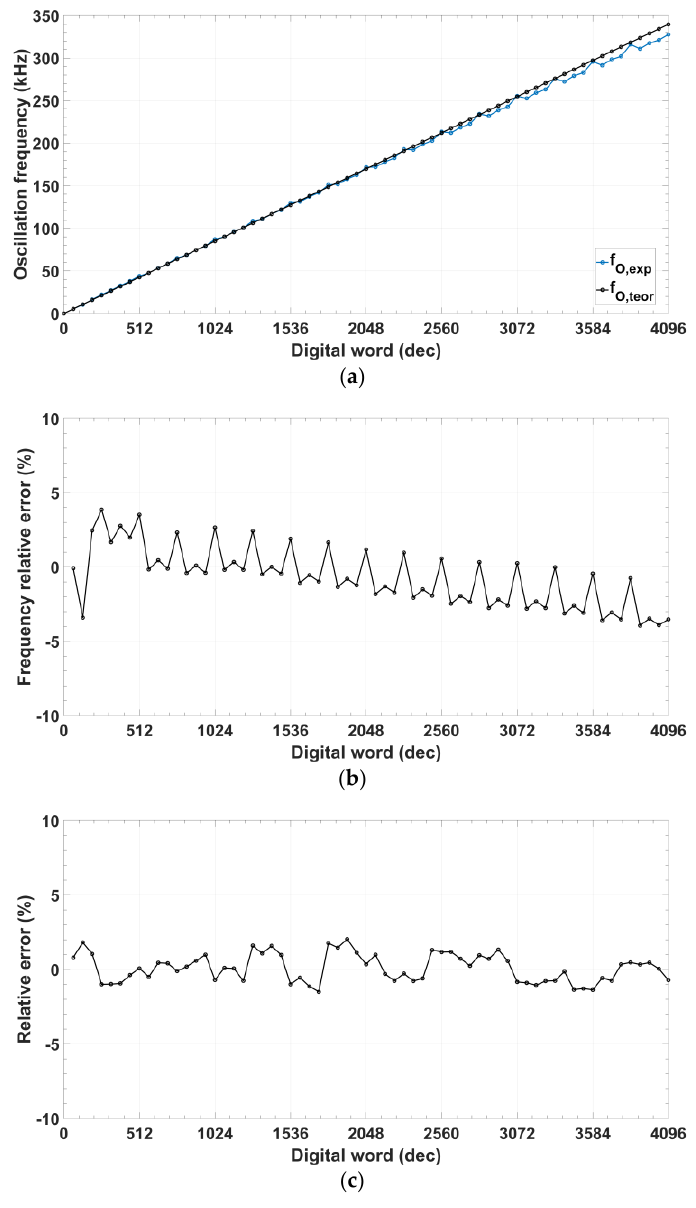
Figure 9. Oscillator dynamic performance measurements: ( a ) Oscillation frequency; ( b ) Frequency relative error; ( c ) Phase relative error.